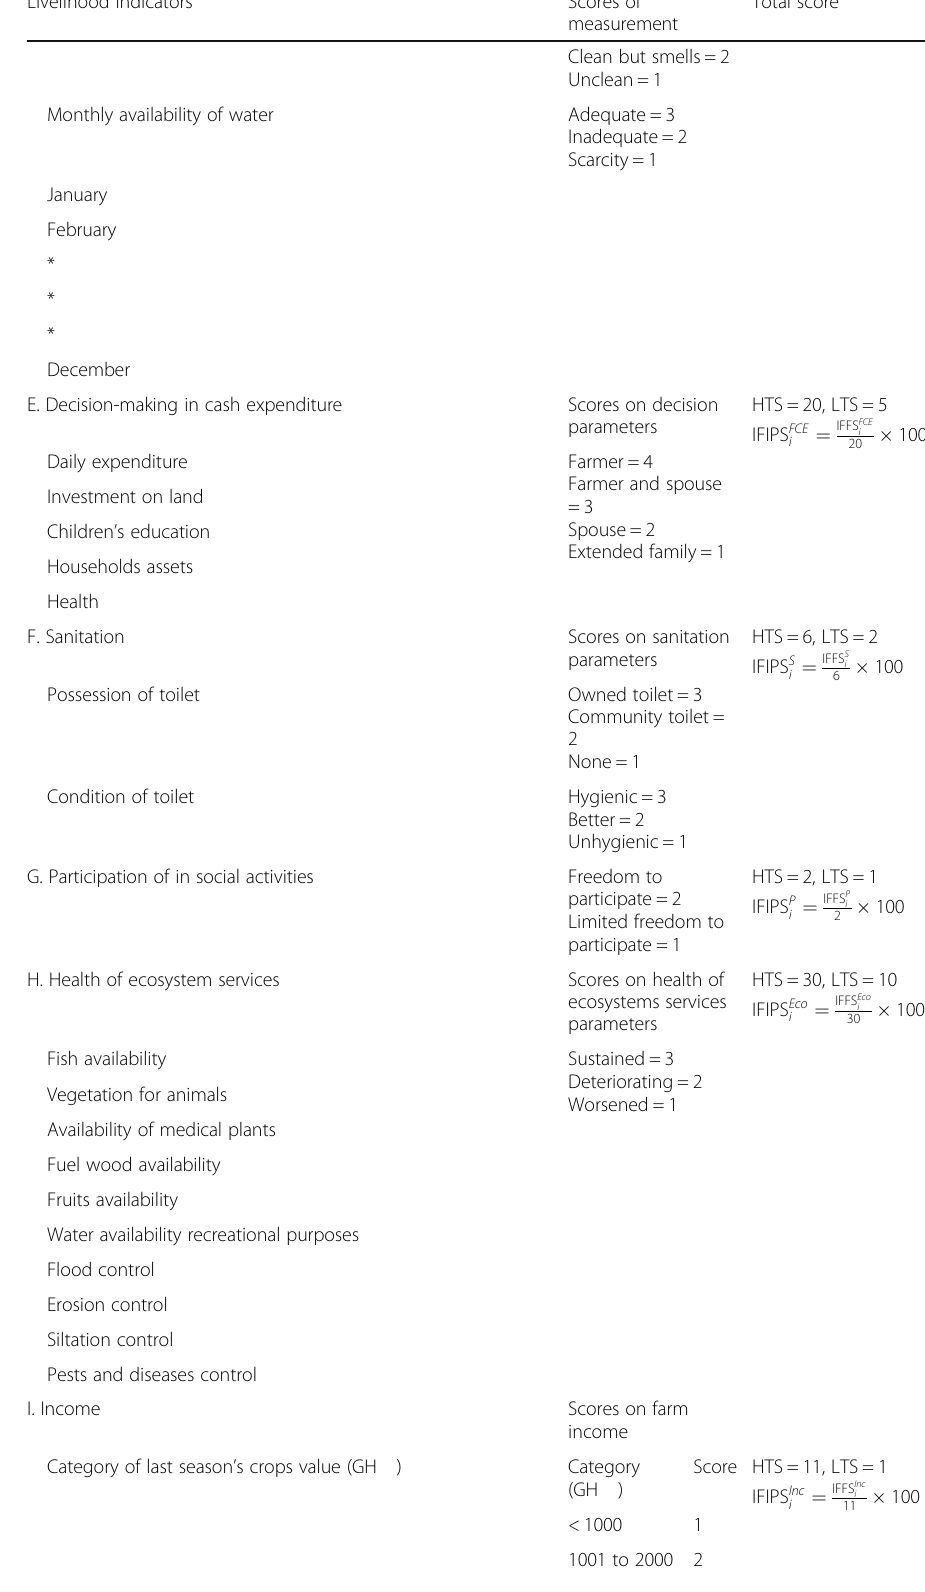
Table 8 Livelihood indicators of farmers and scores of measurements